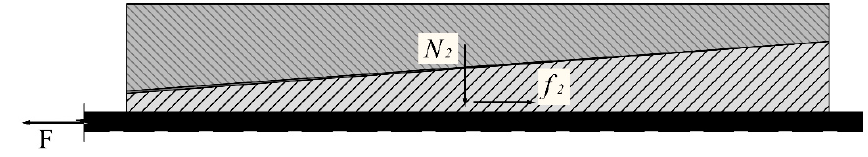
Figure 4. Force diagram of Interface 2.